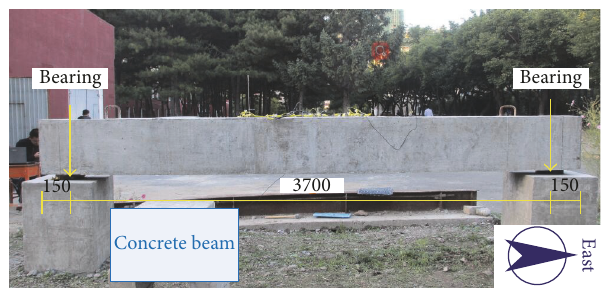
Figure 2: RC beam constructed for monitoring (unit: